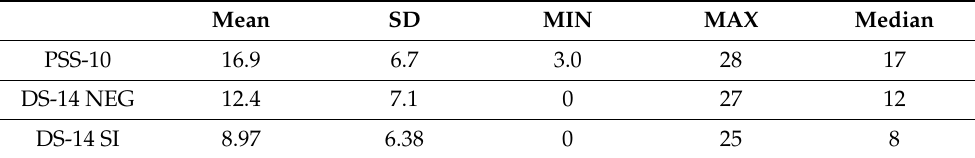
Type-D personality criteria were met by 20 patients (31%). There were no significant differences between the sexes in DS-14 results. DS-14 negative affectivity (NEG) subscores